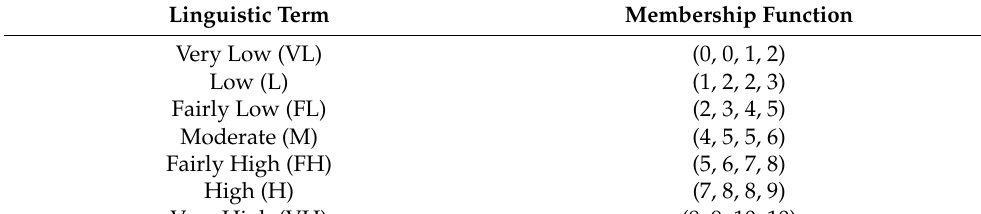
Table 2. Linguistic scale for ranking the improvement strategies.